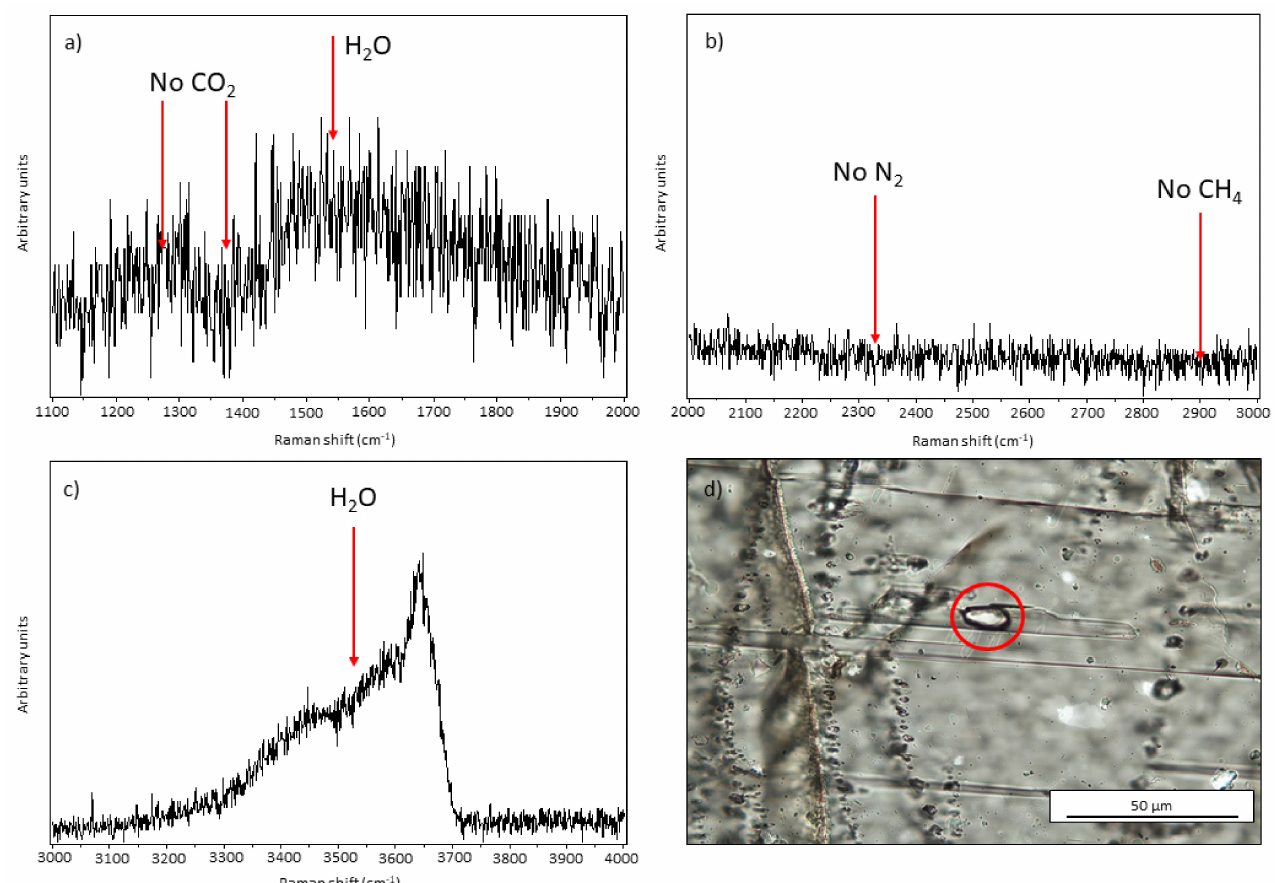
Figure 9. Raman spectra of a garnet-hosted fluid inclusion, showing a H 2 O-rich nature. ( a ) A broad H 2 O peak between 1500 and 1600 cm − 1 and a lack of CO 2 peaks between 1300 and 1400 cm − 1 , ( b ) a lack of N 2 and CH 4 peaks between 2000 and 3000 cm − 1 , ( c ) broad peaks associated with H 2 O between 3200 and 3700 cm − 1 , and ( d ) photomicrograph of the analysed fluid